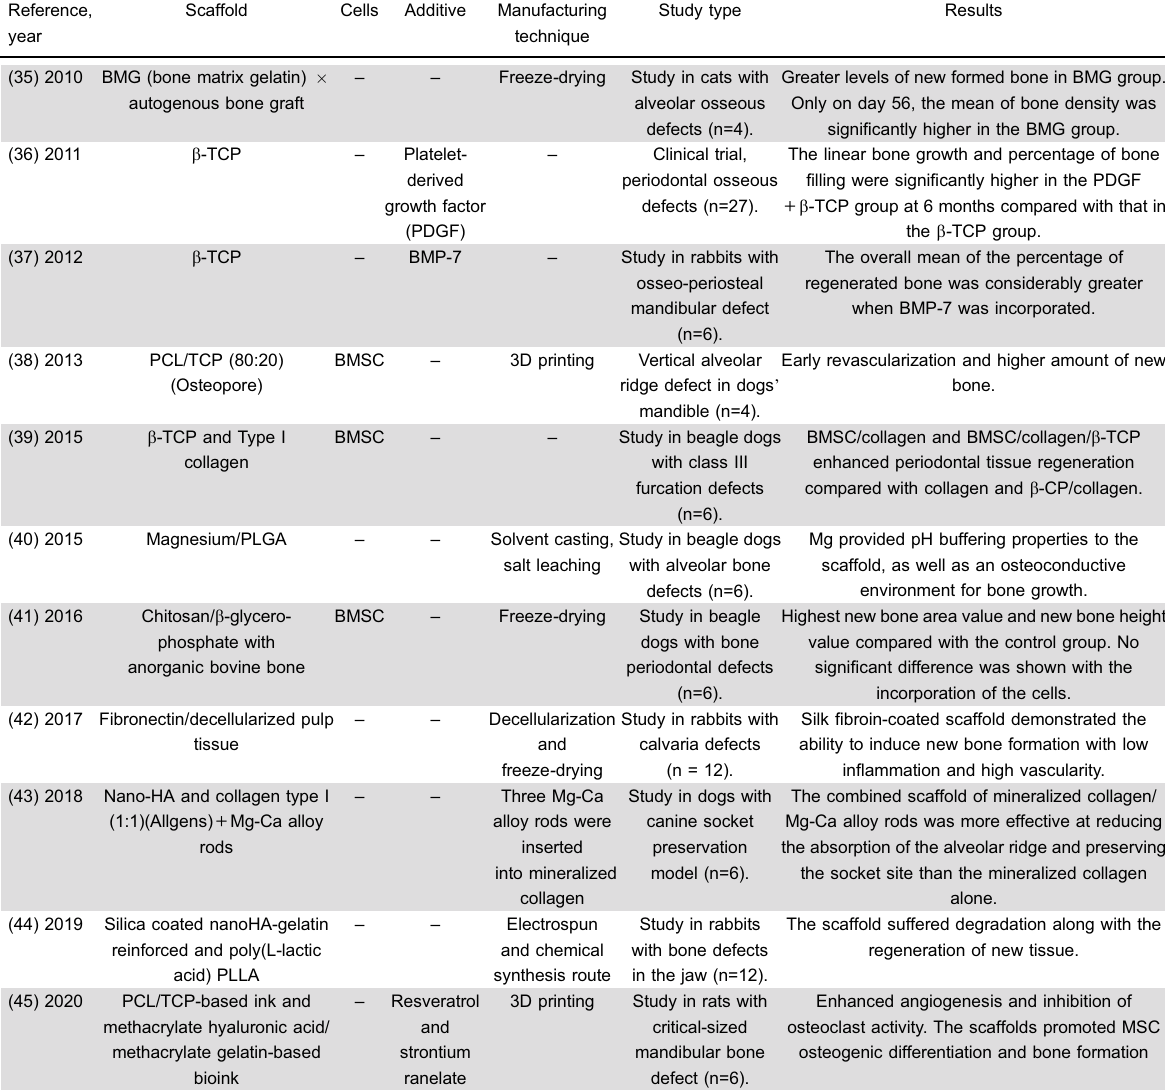
Table 2 . Summary of relevant studies involving scaffolds for bone regeneration in the dentistry fi eld in the last ten years.